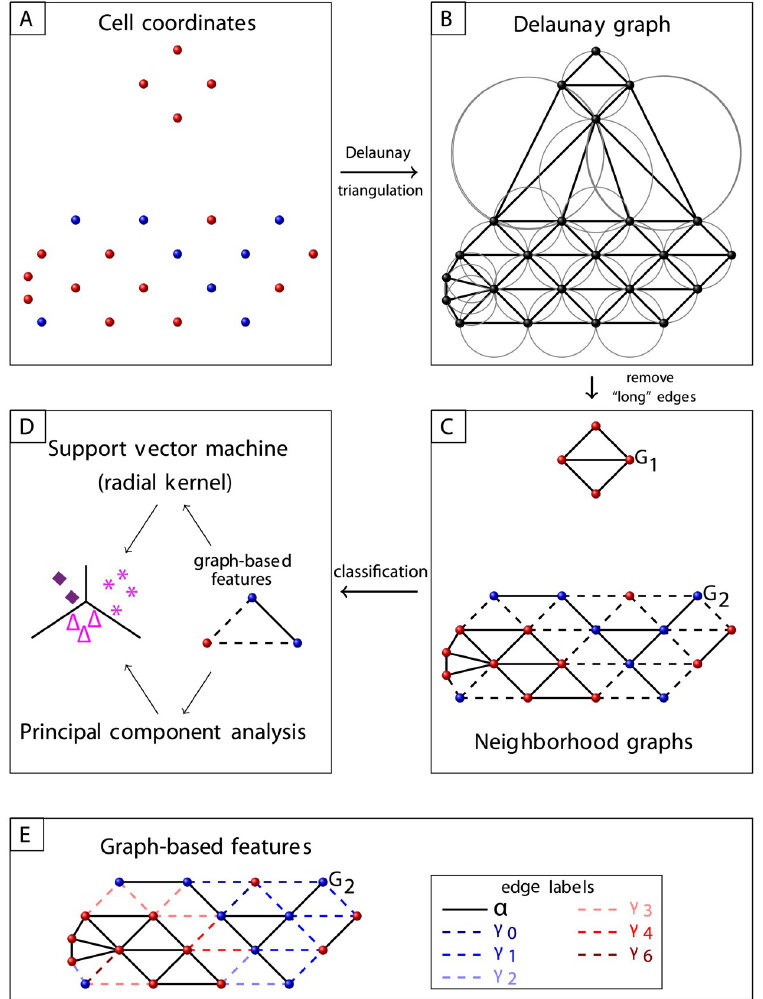
Fig 2. Graph workflow. A: Blue and red dots represent cells of different phenotypes. B: Cells’ Delaunay graph. C: Neighborhood graphs G 1 , G 2 , where triangles with large circumcircle radius were excluded. Edges between cells of different phenotype are illustrated as dashed lines. D: Classification based on the composition of nodes and edges. E: Illustration of edge labels used in the feature κ ( a ), see Section Features of infiltrates; nodes of type A are represented in red. For the illustrated graph G 2 = ( V , E ), k ð 2 Þ ¼ j E g 3 jþj E g 4 jþj E g 6 j j E j(cid:0) j E a